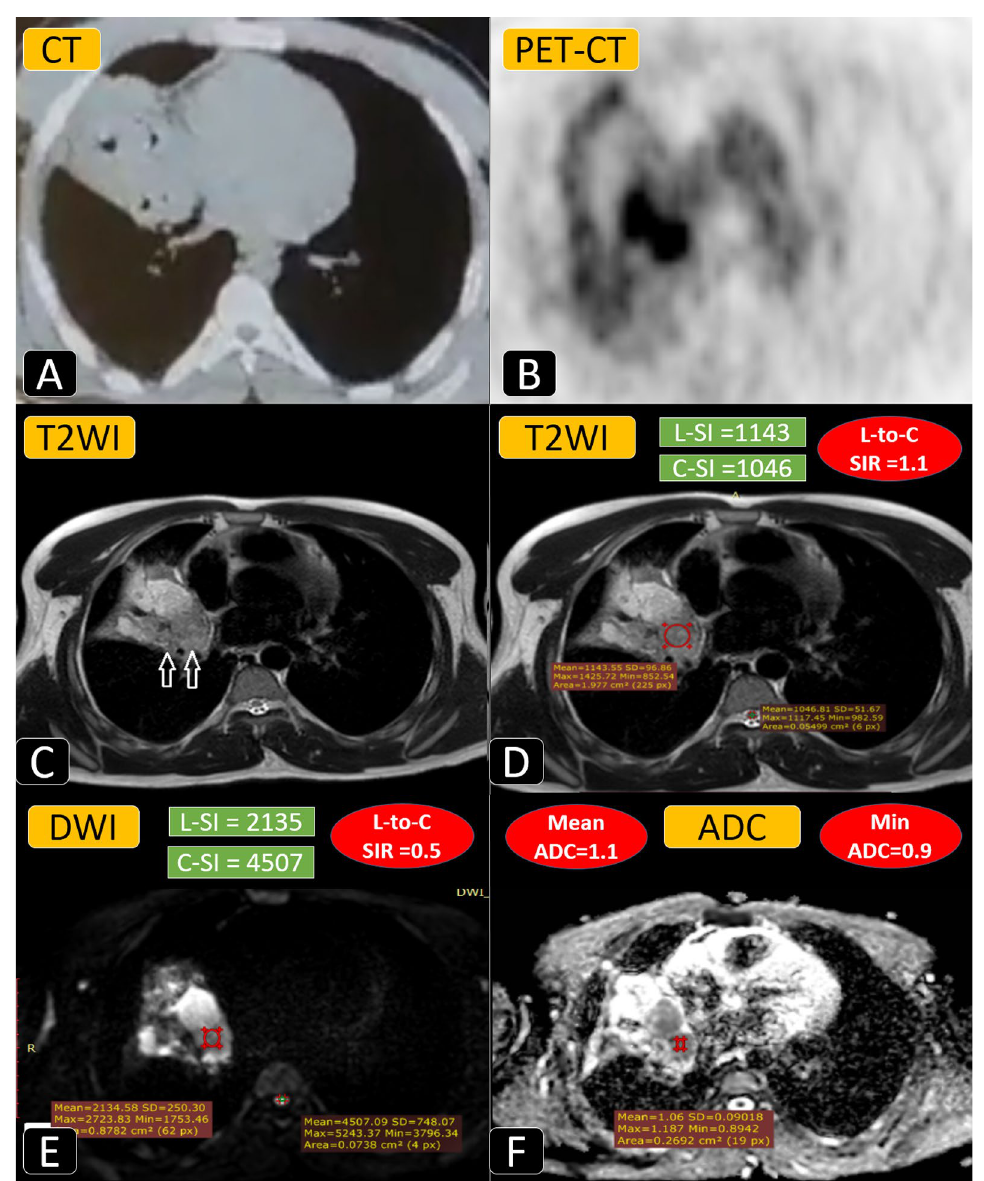
Fig. 4 A 30-year-old male patient complained of chest pain, dyspnea, and hemoptysis. A Axial chest CT cut (mediastinal window) showed right middle lobar consolidation collapse with interrupted air bronchogram and suspected iso-dense central obstructing lesion. B Axial chest PET-CT image showing high 18F-FDG uptake at the right peri-hilar lesion. C, D Axial T2WI showing the heterogeneous high signal intensity of central obstructing lesion with distal atelectasis. After placing two ROIs within the largest lesion and the spinal cord, the lesion-to-spinal cord signal intensity ratio was calculated 1.1. E Axial DWI showing bright signal of restricted diffusion and lesion-to-spinal cord signal intensity ratio was = calculated 0.5. F ADC mapping images showing low signal intensity with minimum ADC (0.9 10 − 3 mm 2 /s) and mean ADC (1.1 10 − 3 mm 2 /s). = × × Referring to the estimated cutoff values, the T2WI L-to-SC SI ratio, minimum ADC, and mean ADC suggested a malignant process; however, the DWI L-to-SC SI ratio was mismatched. Pathologically proven carcinoid